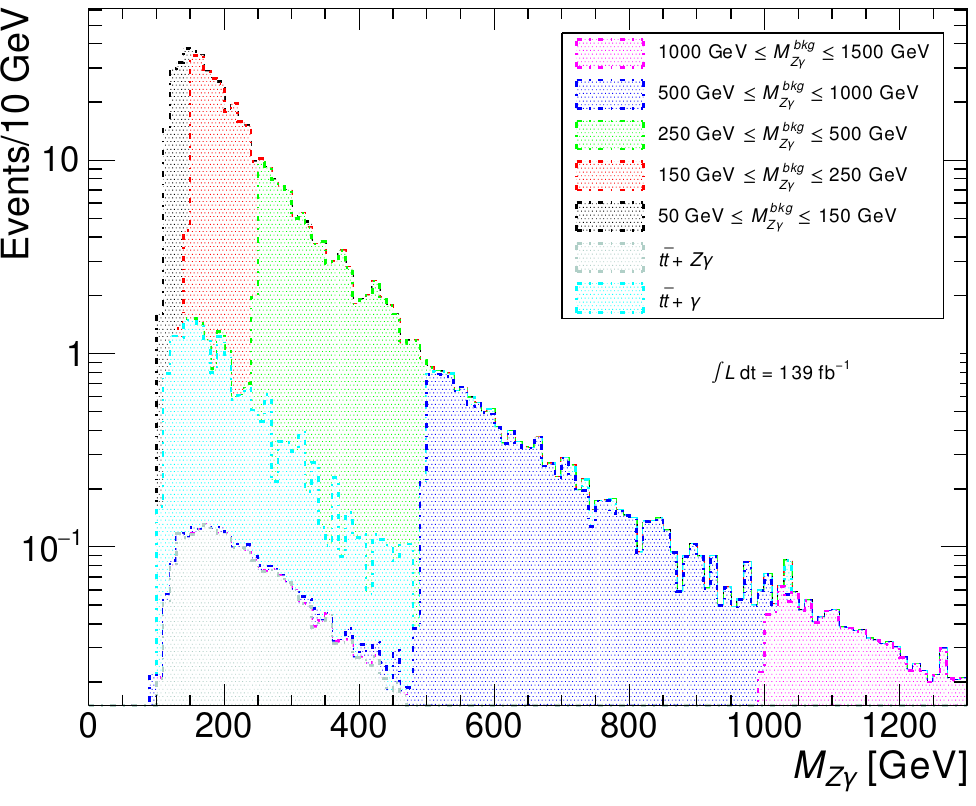
Figure 6 . Invariant mass M Z(cid:13) of the reconstructed Z boson and the photon for each mass slice in the Z (cid:13) + jets background, as well as for the t (cid:22) t + (cid:13) and t (cid:22) t + Z + (cid:13) backgrounds. At least one Z boson, one photon and one b -jet, as de(cid:12)ned in section 4.1, are required. t (cid:22) t + (cid:13) and t (cid:22) t + Z + (cid:13) , is shown in (cid:12)gure 6. In that (cid:12)gure, at least one Z boson, one